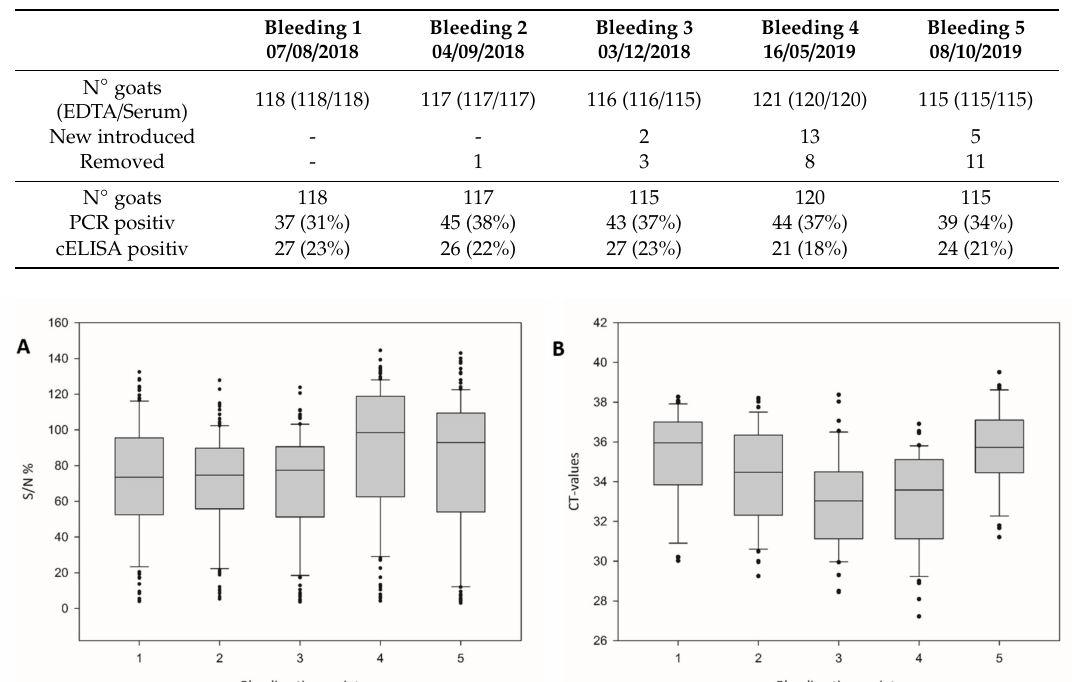
Table 2. Dynamics within the goat flock over the di ff erent sampling time points. The total numbers of positive goats in the BTV-25 specific RT-qPCR (quantification cycle (Cq) < 40) and the cELISA (less than 50% negativity compared to the negative control (S / N)) are shown.